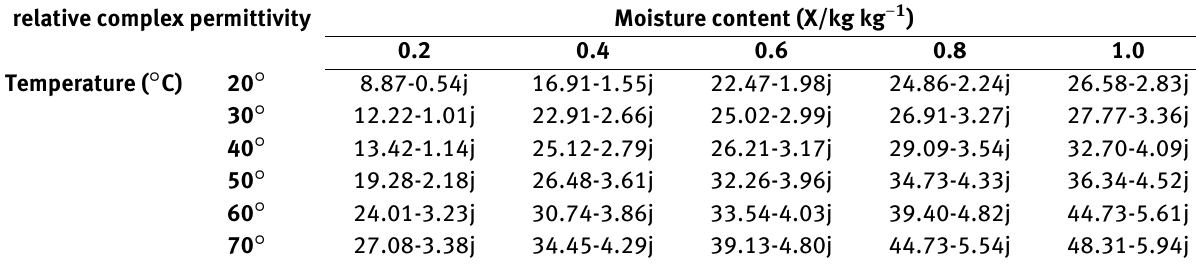
Table 1: The relative complex permittivity of paracetamol at various moisture contents and temperatures (2450 MHz). relative complex permittivity